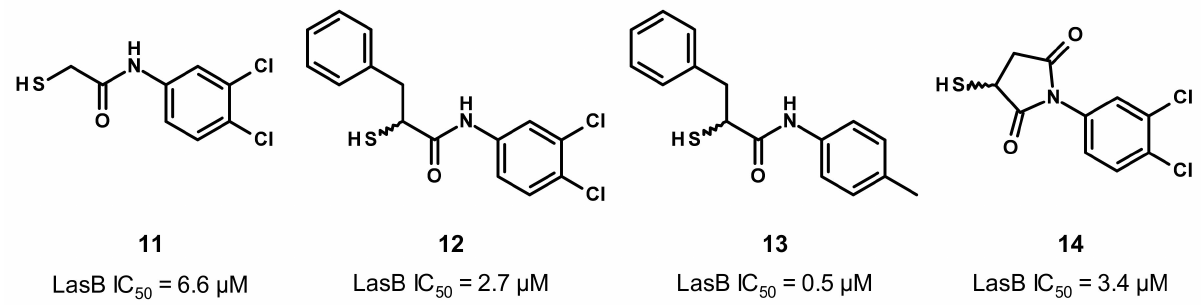
Figure 6. Chemical structures and inhibitory activities of the thiols 11 – 14 . IC 50 values were extracted from the original publications